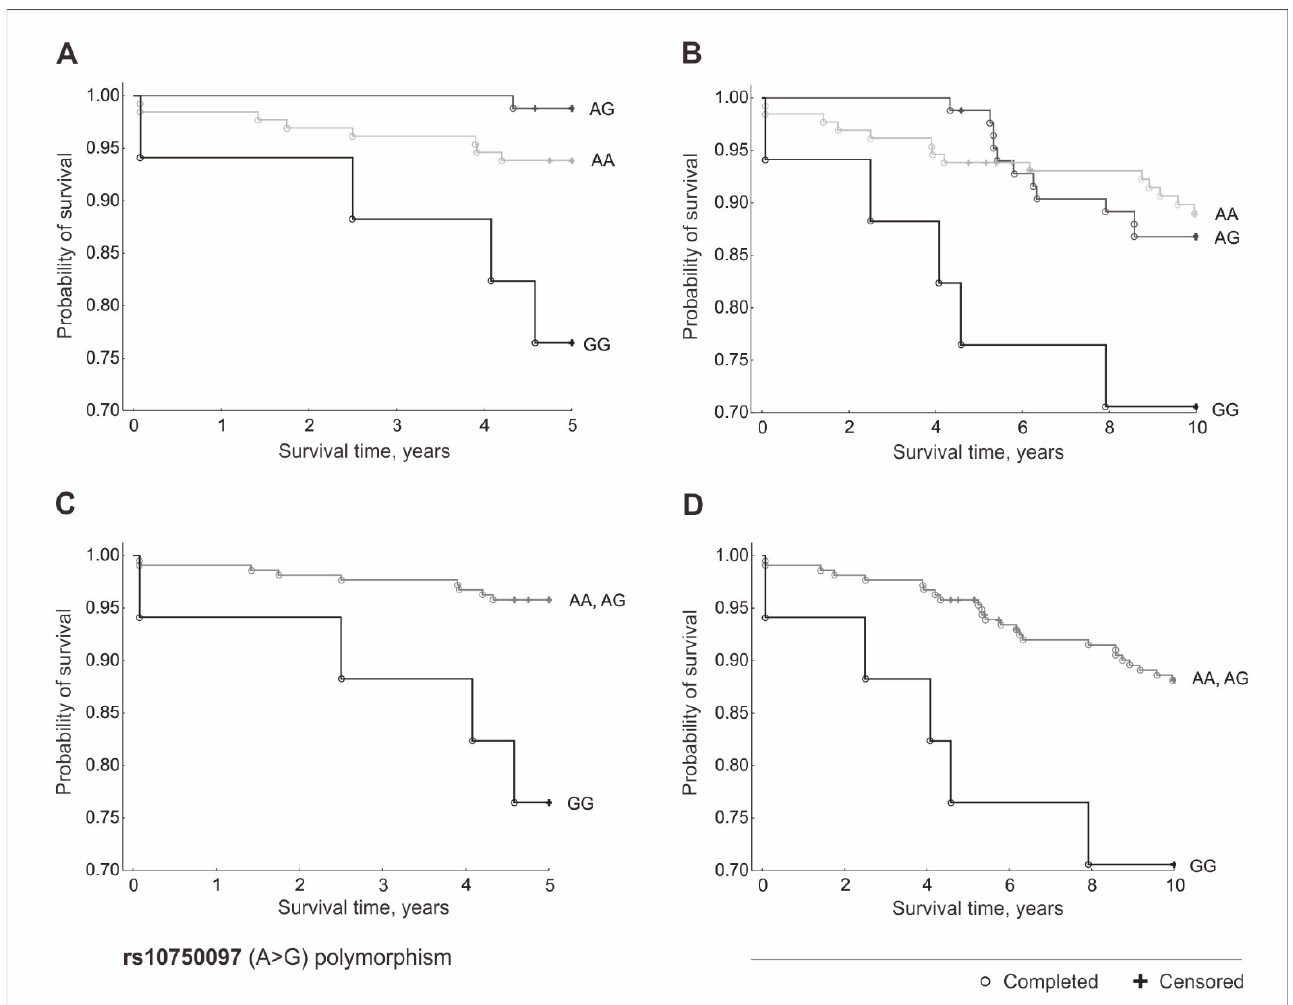
Figure 2. Kaplan – Meier survival curves for CAD patients by rs10750097 (A > G) polymorphism: ( A ) 5-year survival in additive model; ( B ) 10-year survival in additive model; ( C ) 5-year survival in a recessive model; ( D ) 10-year survival in a recessive model.